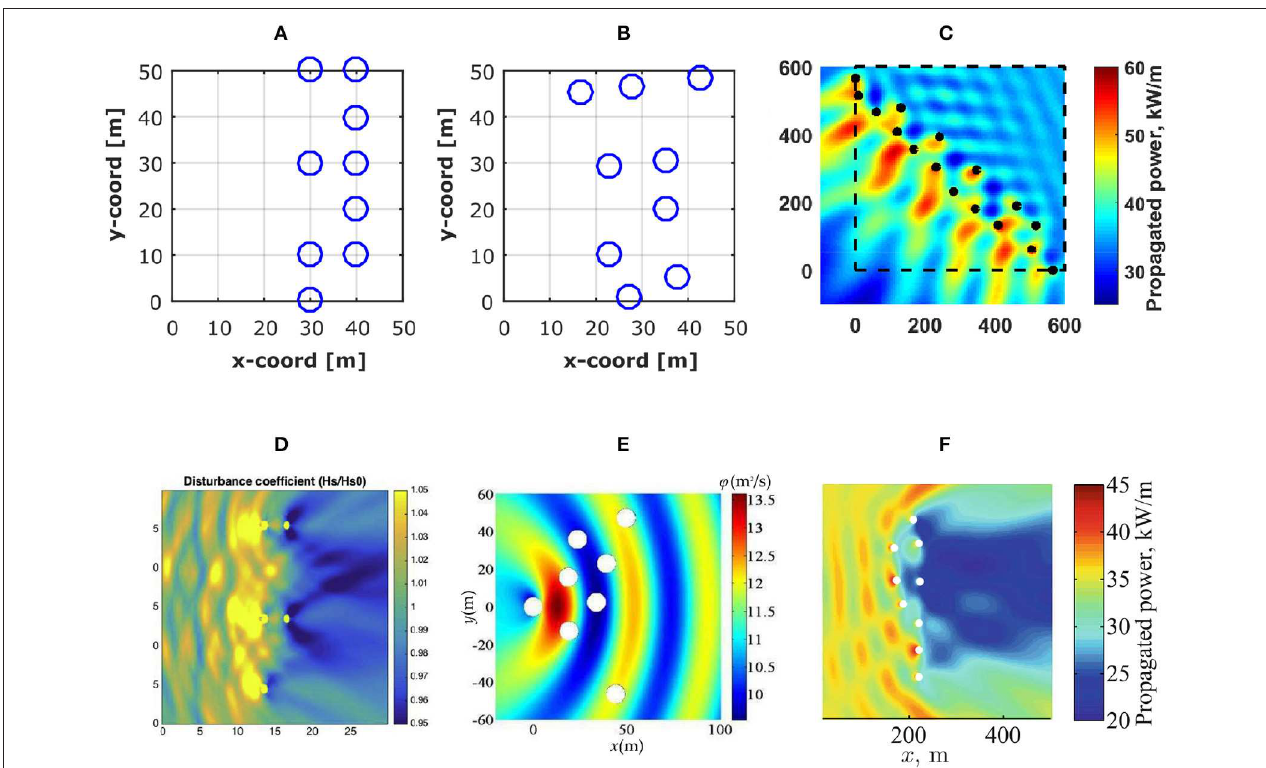
FIGURE 12 | Corresponding optimization as in Figure 11 but for the case when the allowed area for the park does not allow for the WECs to all align perpendicular to the predominant wave direction. The waves are propagating along the x -direction in all figure parts except for (C) , where the wave direction is a narrow interval around 240 ◦ . (A,B) GA optimization in long-crested waves with a gridded and continuous layout, respectively ( Giassi and Göteman, 2018). (C) Optimal layout of 16 WECs ( Neshat et al., 2019b). (D) GA optimization for the case of a 3-m minimum separation distance (Sharp and DuPont, 2018). (E) Optimal eight-WEC array layout obtained in Fang et al. (2018) with an evolutionary algorithm and regular waves. (F) Multi-objective optimization of array with nine WECs (Arbonès et al., 2018).